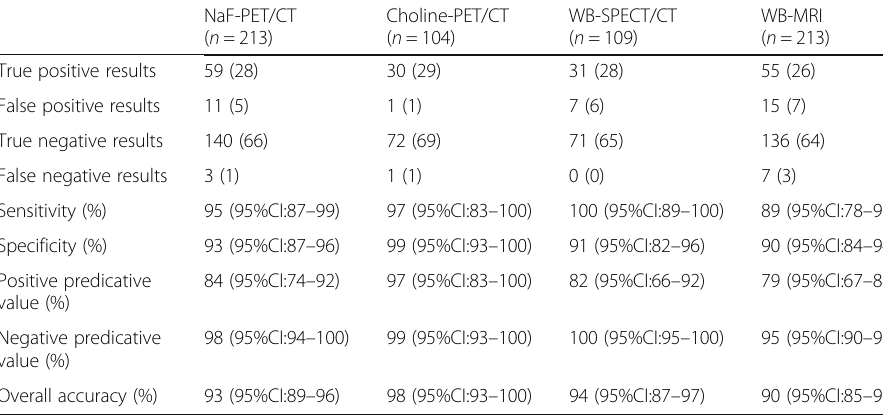
Table 2 Characteristics of study participants with versus without bone metastatic disease Parameter Bone metastatic PSA Mean PSA at primary diagnosis (ng/mL)